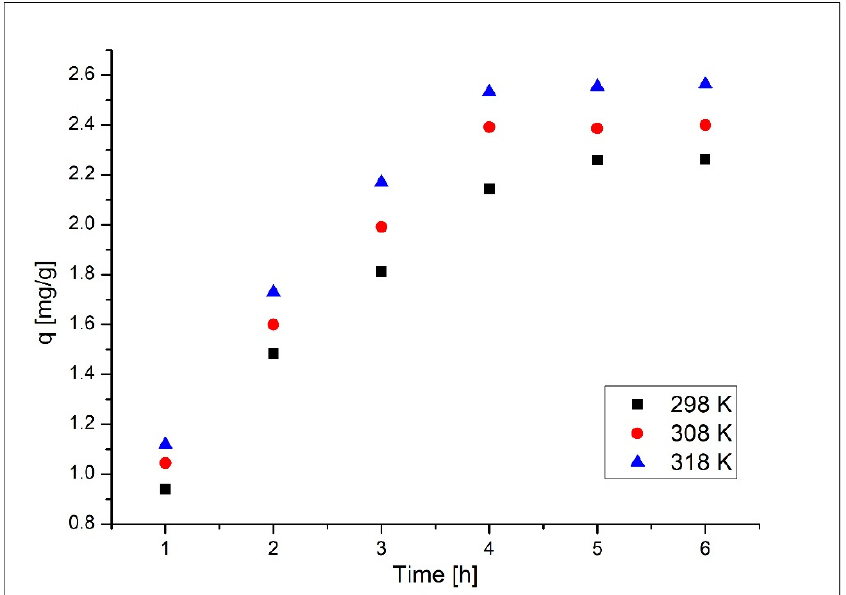
Figure 8. Influence of contact time and temperature on adsorption capacity.